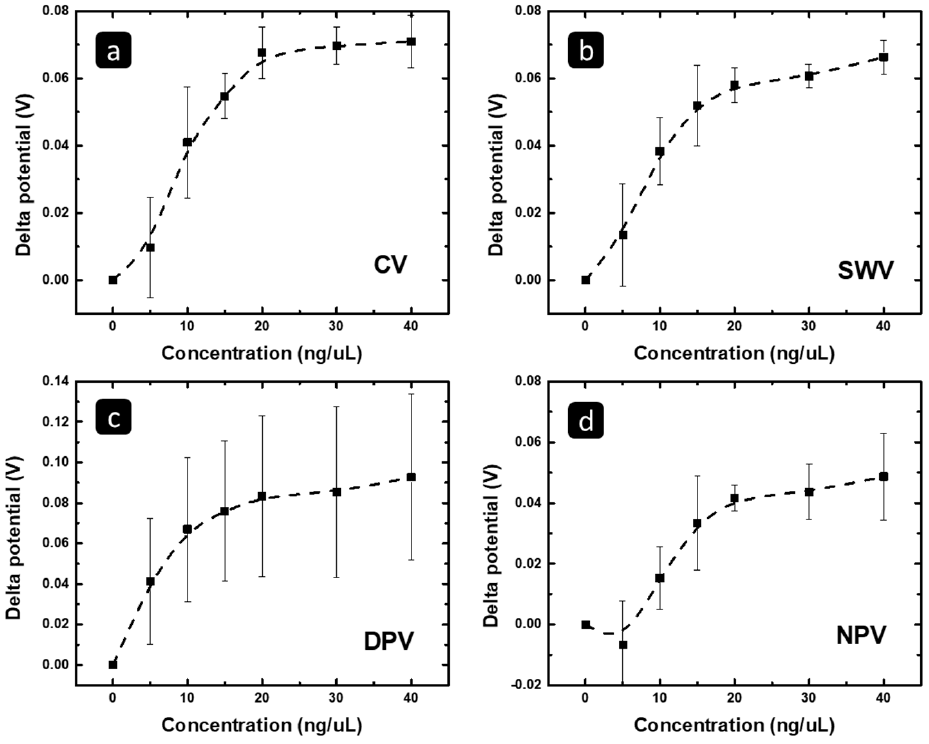
Figure 5. The correlation between the ( a ) CV, ( b ) SWV, ( c ) DPV, and ( d ) NPV potential change versus the concentration (deposited amount) of the MCF 7 exosomal RNA.